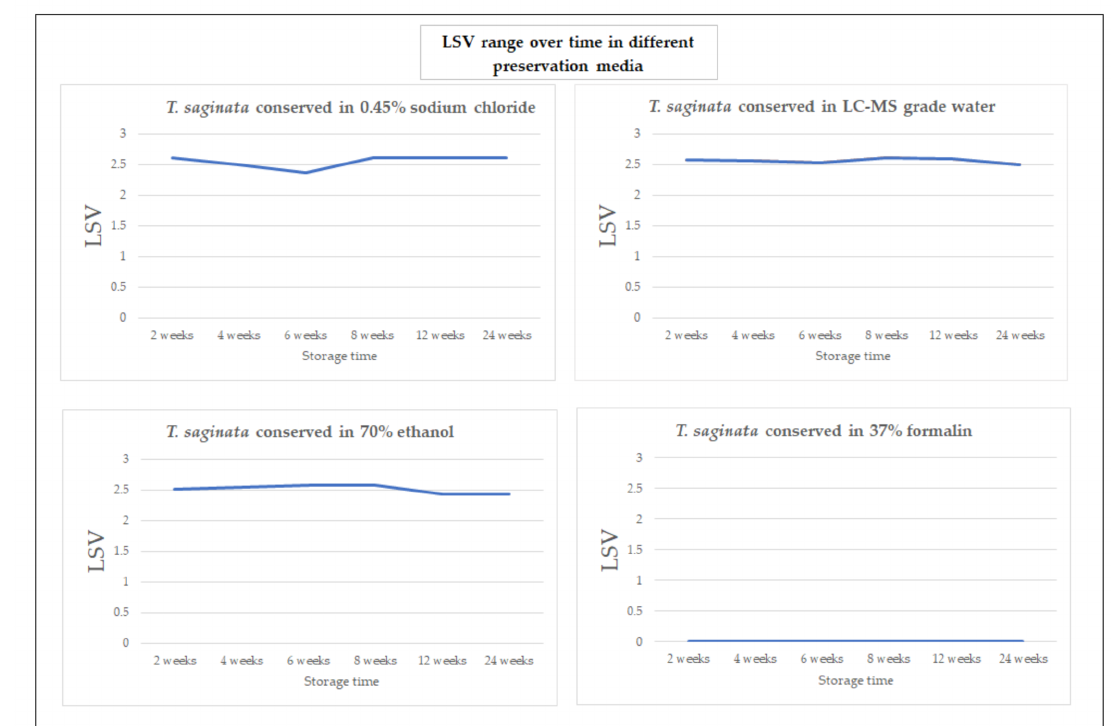
Figure 2. Average LSVs of protein spectra stemming from Taenia proglottids in different preservation media during a 24-week observation period. Spectra were identified using a combination of Bruker Taxonomy and an in-house helminth database.